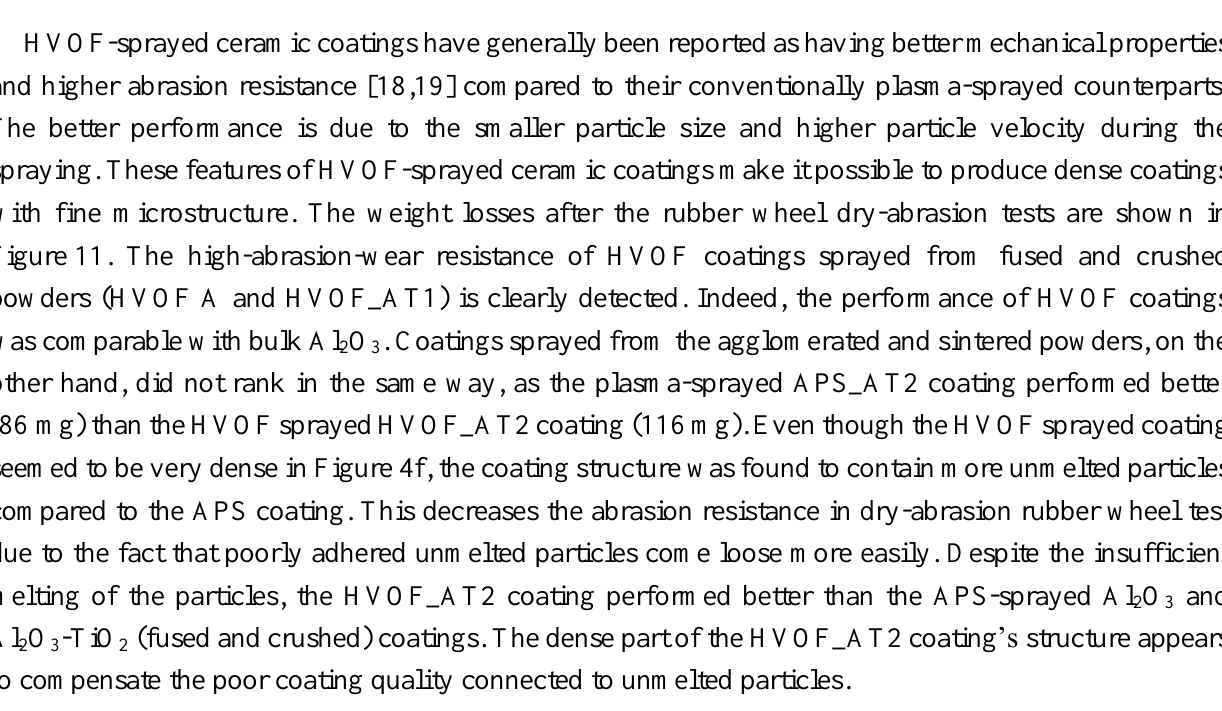
Figure 11. Weight losses and standard deviations of the APS and HVOF coatings and bulk Al O material after abrasion wear 2 3